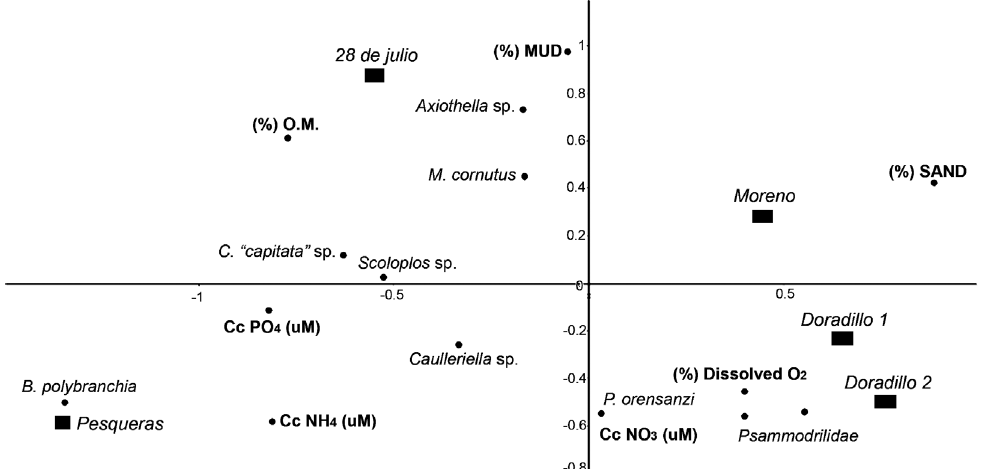
Fig . 4. – Redundancy analysis (RDA) showing collection sites, the main environmental variables and